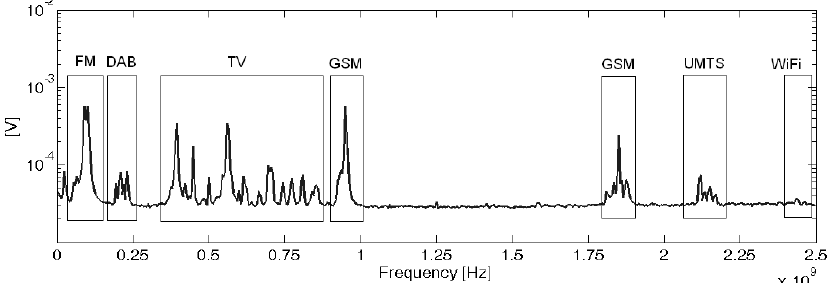
Figure 4. Spectrum of the interferences in the laboratory captured by the antennas without voltage applied to the test objects.